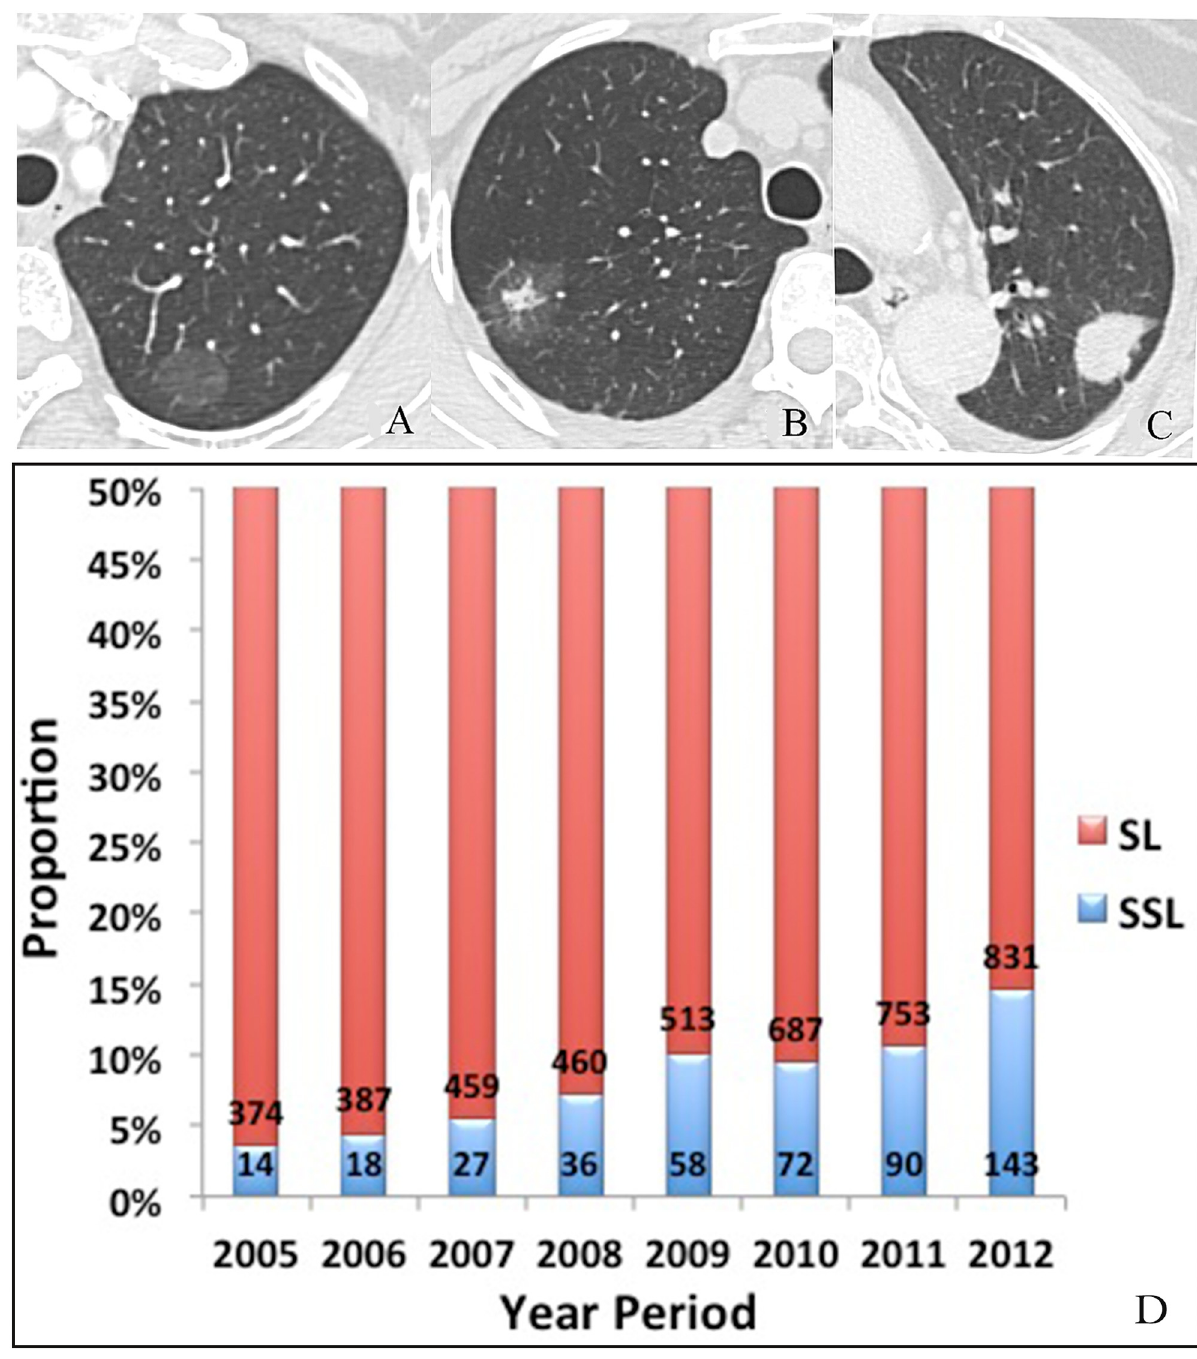
Fig 4. A-C: Various imaging features of ADC in HRCT images, D: Distribution of ADC with SN and SSN in CHCAMS from 2005 to 2012. A. pure ground-glass nodule, B. part-solid lesion, C. solid